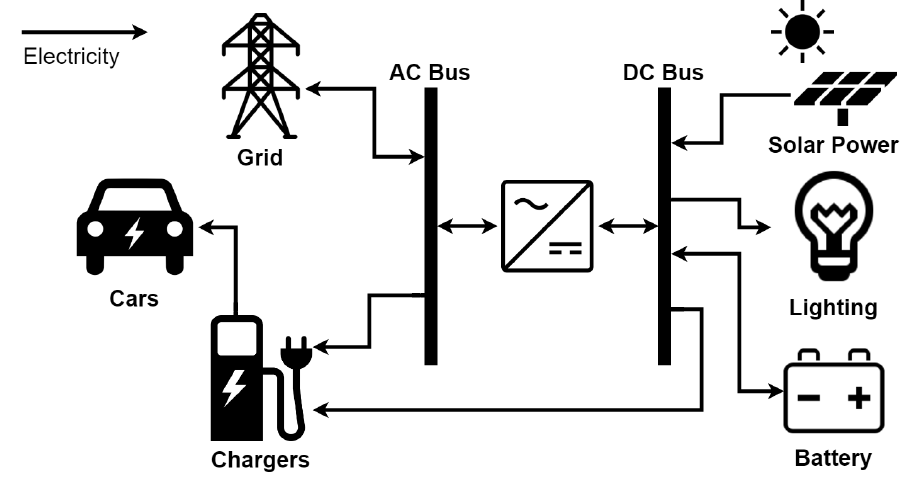
Figure 1. System configuration of a smart solar parking lot.